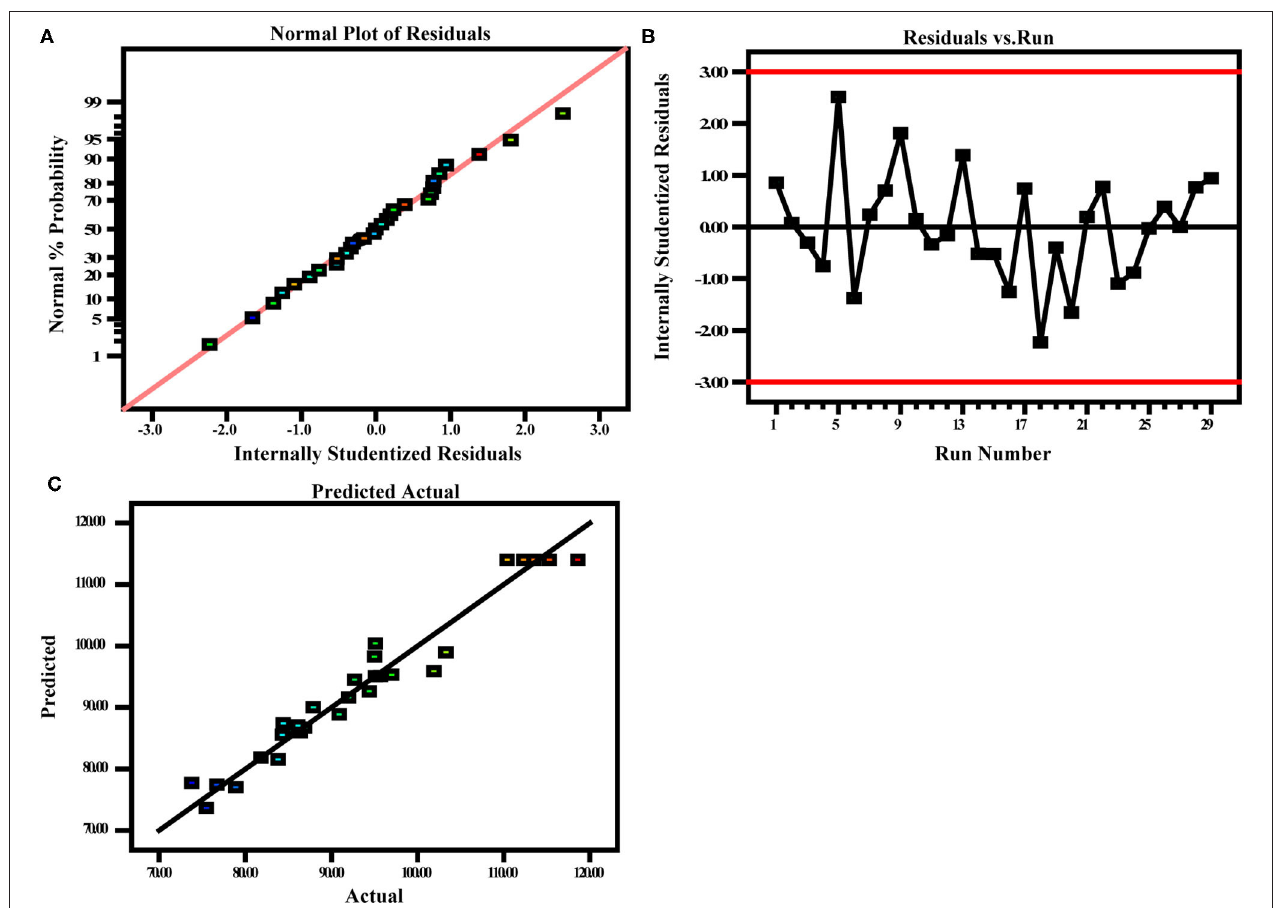
FIGURE 6 | Three diagnostic plots for model adequacy checking. Normal plots (A) , residuals vs. run number (B) , and predicted vs. actual (C) .